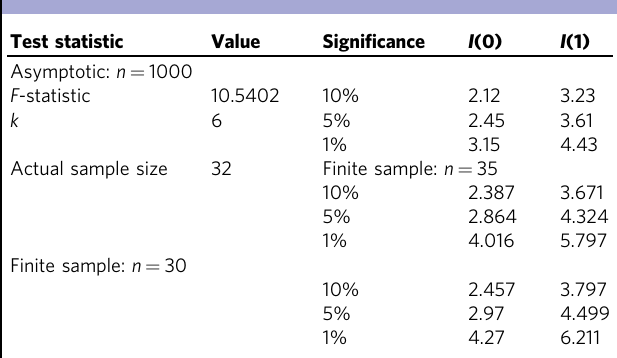
Table 3 Bounds test